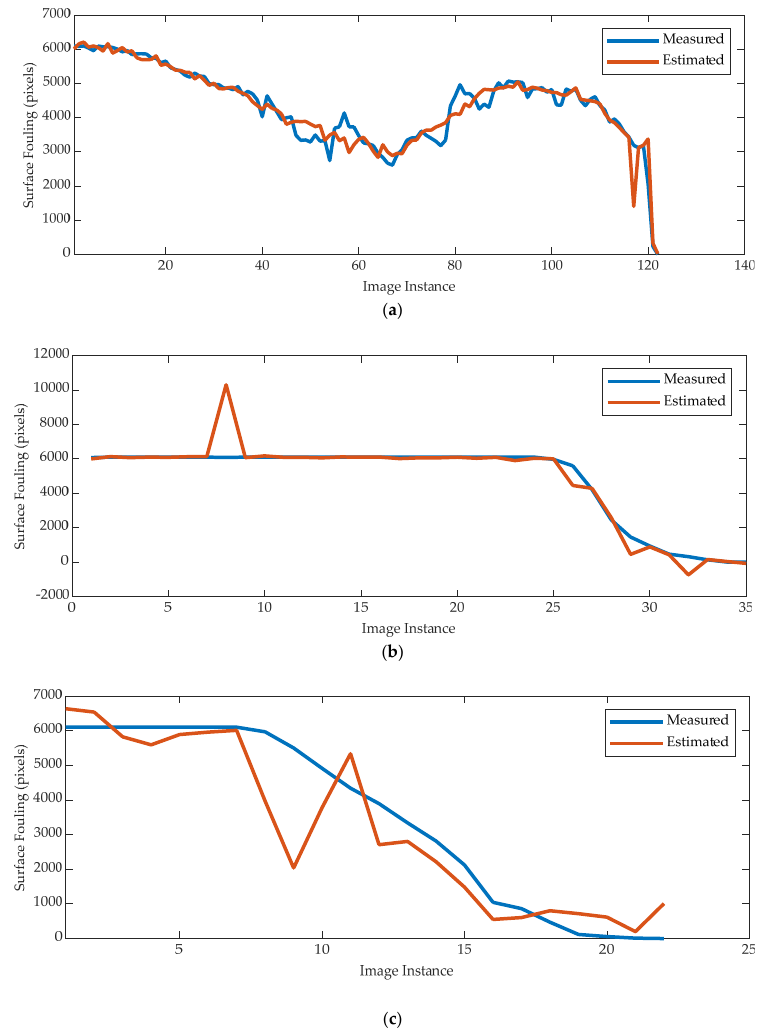
Figure 13. Measured surface fouling versus NN estimations for gravy_cold_1 ( a ), malt_cold_2 ( b ), and tomato_cold_1 ( c ) tests.